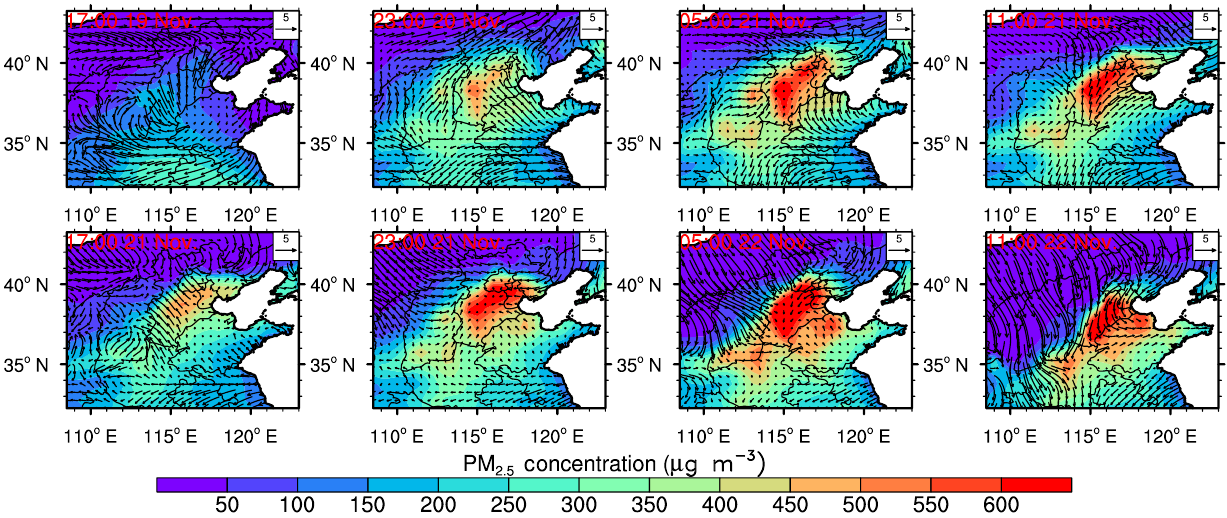
Figure 9. Variations of simulated surface PM 2 . 5 concentrations and wind field